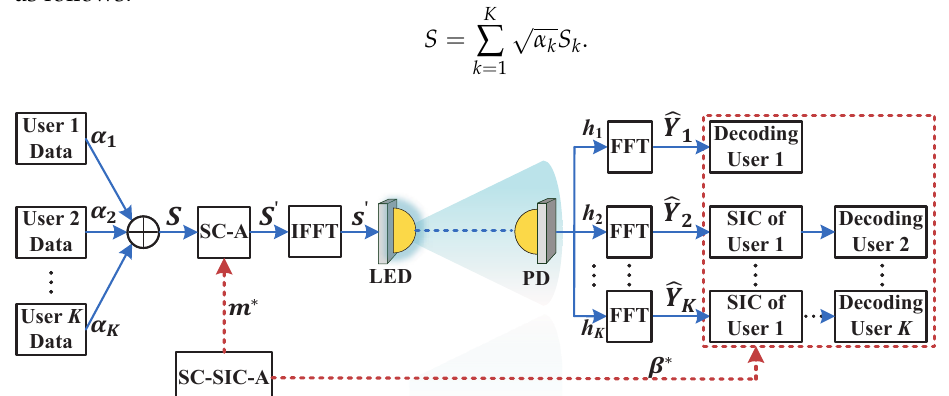
Figure 1. The schematic of the downlink multi-user NOMA VLC system using joint transceiver